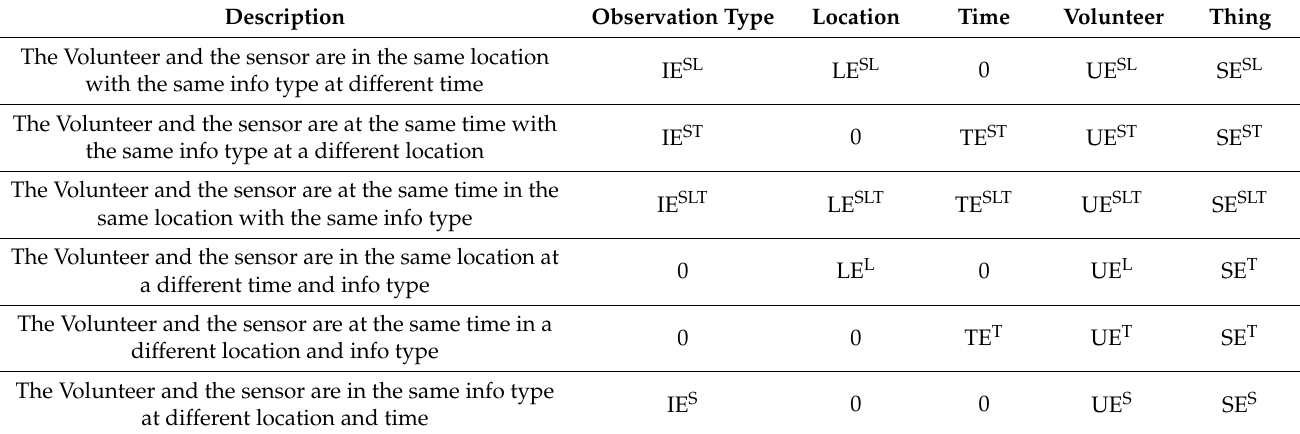
Table 1. Hypergraph incidence matrix of the proposed